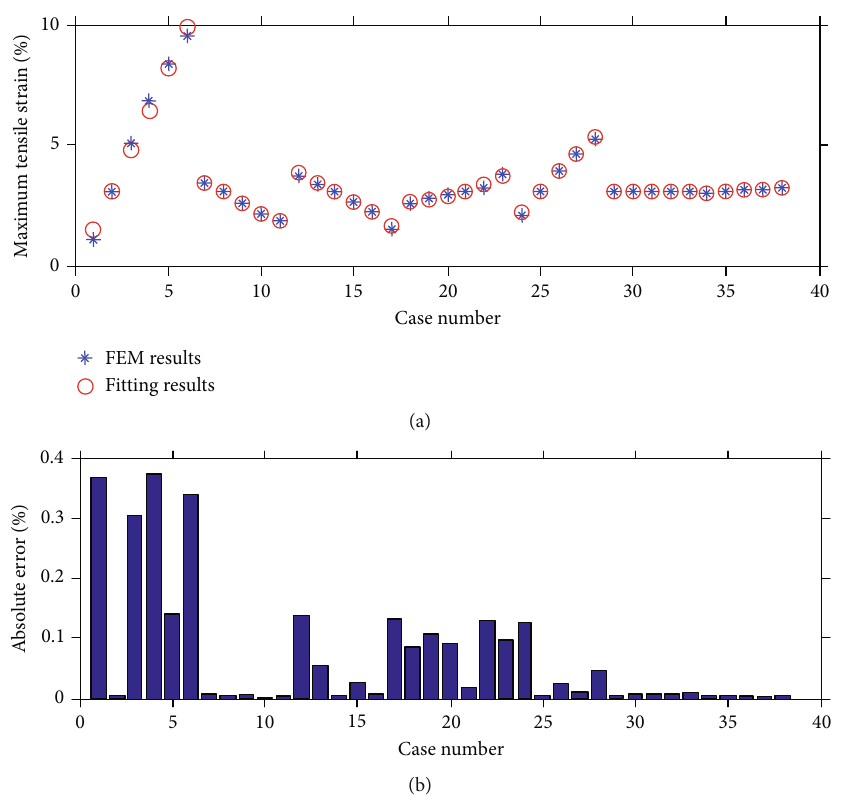
Figure 15: Comparison between semiempirical equation and FEM results for maximum tensile strain: (a) maximum tensile strain and (b) absolute